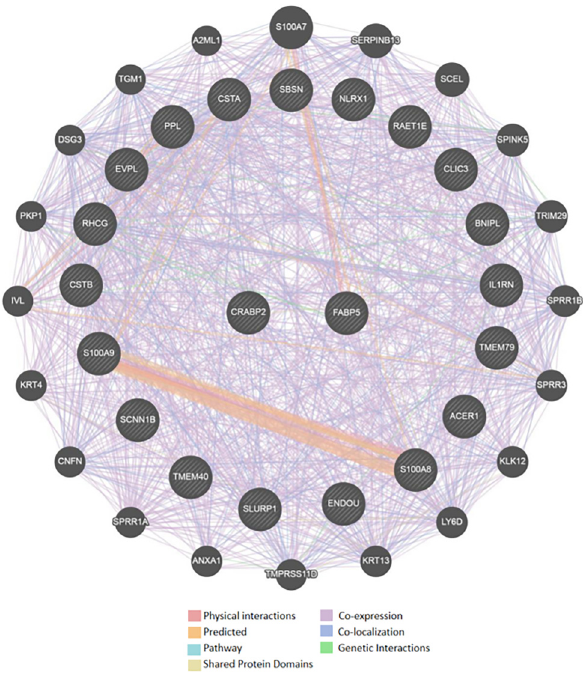
Figure 4: Genemania analysis of CRABP2 interaction proteins.